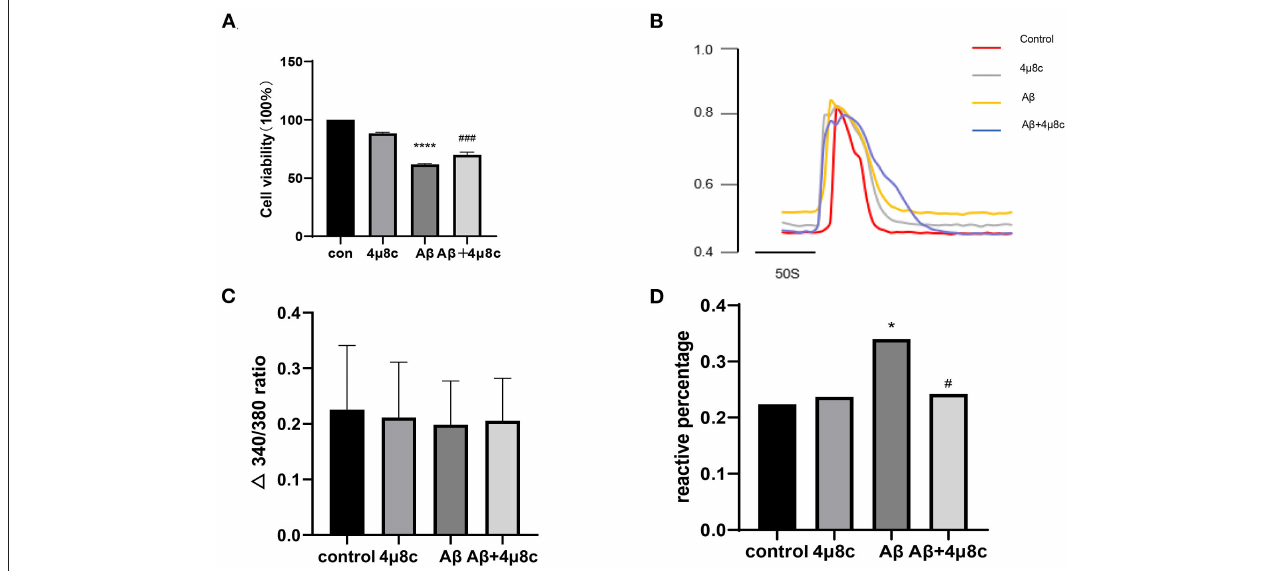
FIGURE 2 | The effect of the IRE1 α -XBP1 activation on the viability of A β -treated cells. Cells were pretreated with or without 20 µ M 4 µ 8c for 6h, followed by treatment with 20 µ M A β 25–35 for 24h. (A) Cell viability was measured using the 3-(4,5-dimethylthiazol-2-yl)-2,5-diphenyltetrazolium bromide (MTT) assay. (B) Representative trace of Ca 2 + upon 1 µ M bradykinin (BK) stimulation. (C) The amplitude of 1 µ M BK-evoked Ca 2 + increase was calculated as the difference between the peak and the baseline. (D) The number of cells that responded to BK was quantitatively analyzed and is expressed as a percentage of the response. The data are presented aes mean ± SD, * P < 0.05 compared with the control. **** P < 0.0001 compared with the control. # P < 0.05 compared with the A β 25–35-alone group. ### P < 0.001 compared with the A β 25–35-alone group.